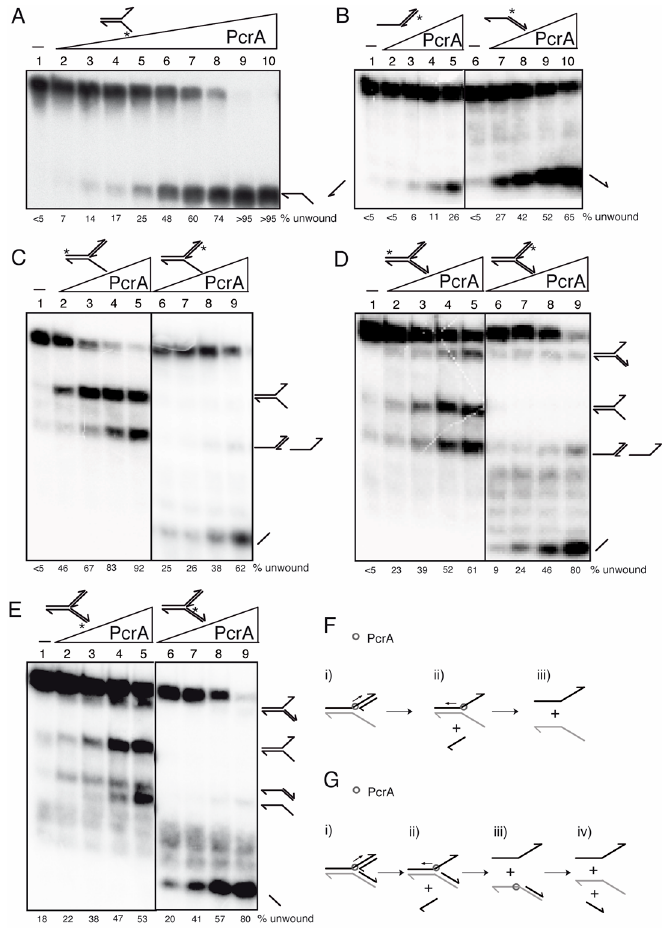
Figure 5. PcrA preferentially unwinds DNA in the 3 ′ → 5 ′ direction. Helicase assays with [ γ 32 P]- flayed ( A ), [ γ 32 P]-5 ′ - and [ γ 32 P]-3 ′ -tailed duplexes ( B ), [ γ 32 P]-3 ′ -fork DNA ( C ), and [ γ 32 P]-Y-fork ( D , E ) were performed with increasing concentrations of wt PcrA (0.1–25 nM ( A ) or 1.5 to 12 nM ( B – E )). Reactions were done in buffer D containing 2.5 mM ATP (15 min, 37 °C), and after deproteinization the substrate and products were separated by 6% PAGE in TG buffer, and visualized by phosphor imaging. Cartoons showing the proposed mode of action for PcrA ( F , G ). Abbreviations: -, absence of PcrA; *, indicates the [ γ 32 P]-labeled strand; half arrow head, denotes the 3 ′ -end. When a [ γ 32 P]-flayed DNA substrate (0.25 nM, in DNA molecules) was incubated with increasing PcrA concentrations (0.1 to 25 nM), the unwinding of 50% of the [ γ 32 P]- fork DNA substrate was achieved with ~1.5 nM PcrA (Figure 5A, lanes 5–6), suggesting that PcrA efficiently unwinds the flayed DNA (non-replicated fork). PcrA shows a ~9- fold preference for the 3 (cid:48) -tailed duplex substrate (Figure 5B, lanes 5 vs. 7). These data confirmed that PcrA preferentially unwinds a non-replicated fork DNA and a 3 (cid:48) -tailed duplex substrates in the 3 (cid:48) → 5 (cid:48) direction (Figure 5A,B)